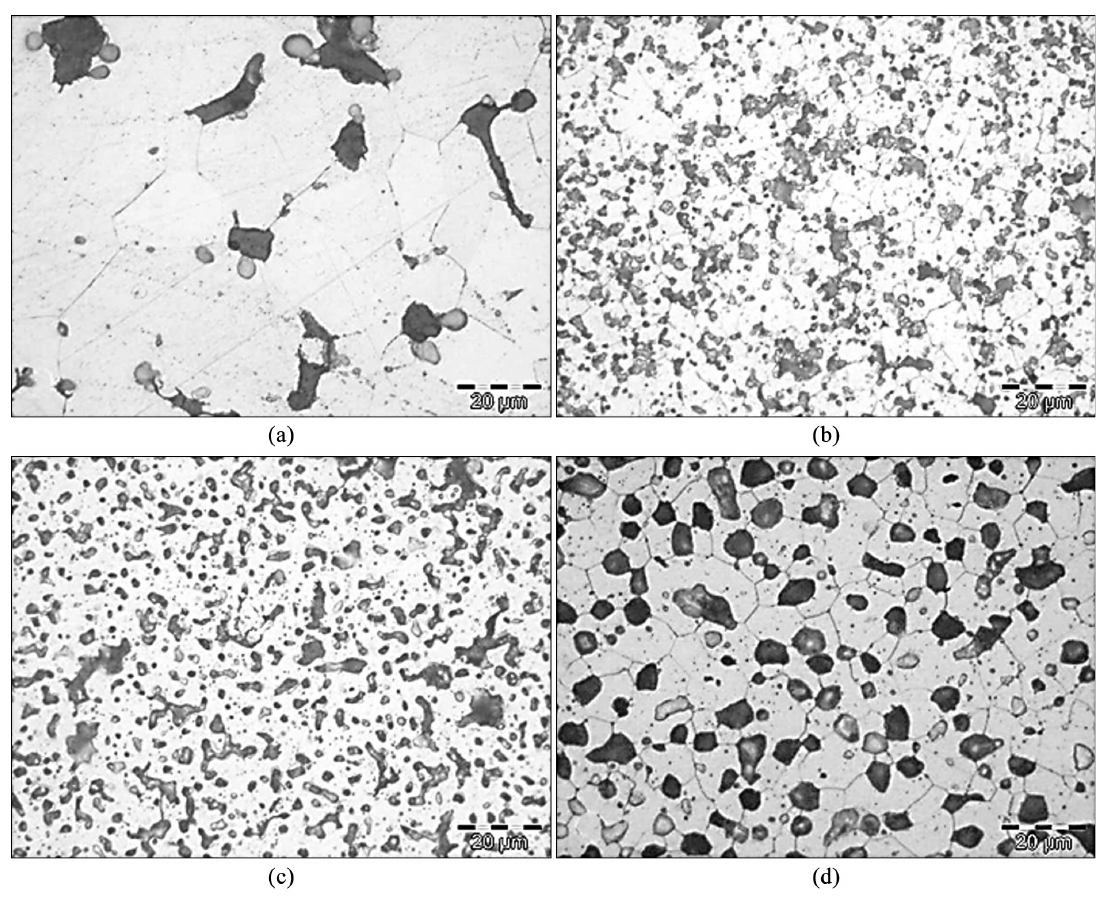
Figure 7. Micrograph of alloy: FeSiP – (a) 0h, (b) 1h, (c) 6h and (d) 9h. Attack with Nital 2%.